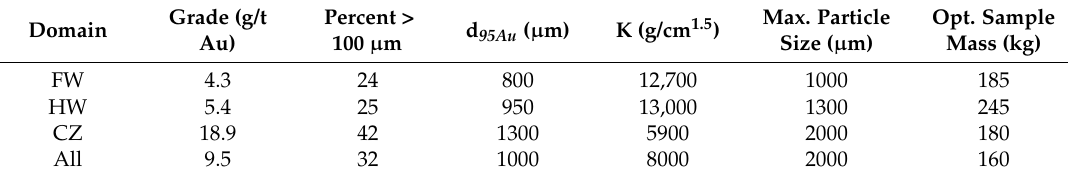
Table 14. Sampling characteristics by SVZ mineralisation domain based on bulk sample processing.